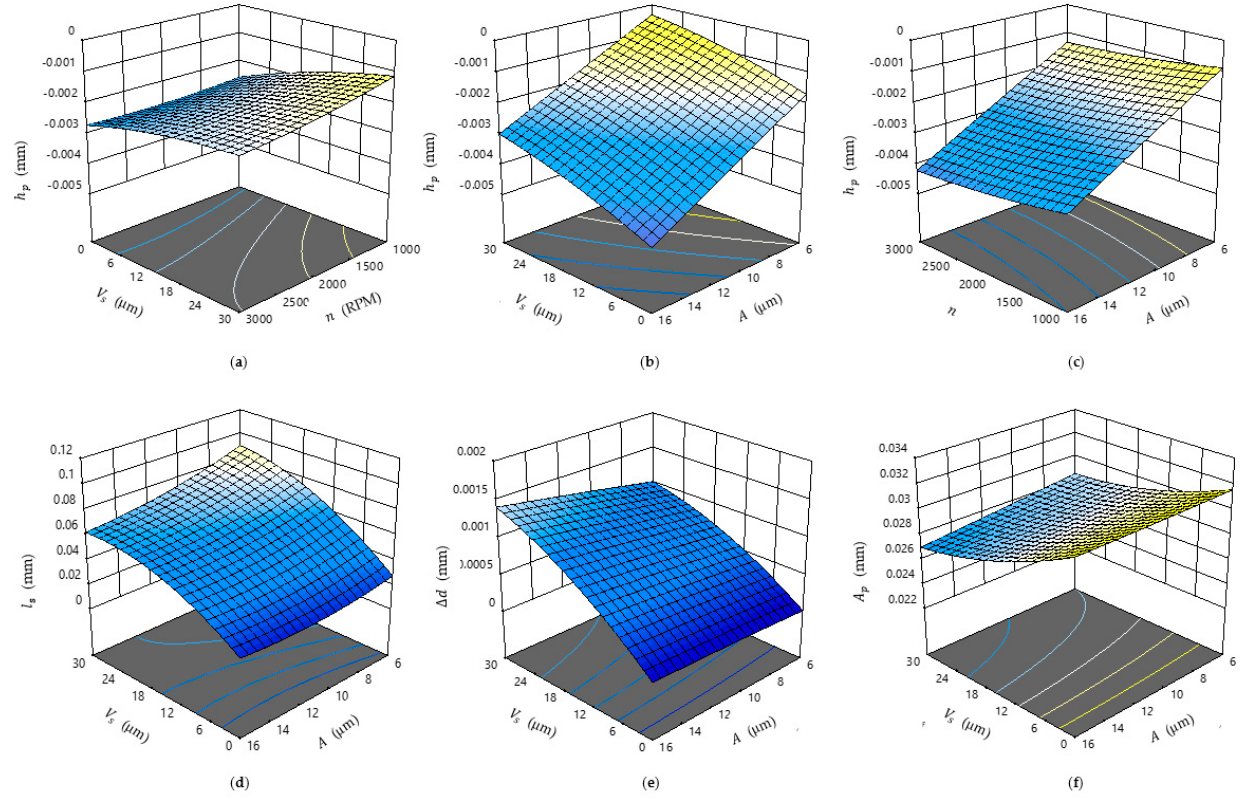
Figure 3. RSA of the relative parameters: ( a ) V s − n − h p , ( b ) V s − A − h p , ( c ) n − A − h p , ( d ) V s − A − l s , ( e ) V s − A − ∆ d , and ( f ) V s − A − A p .